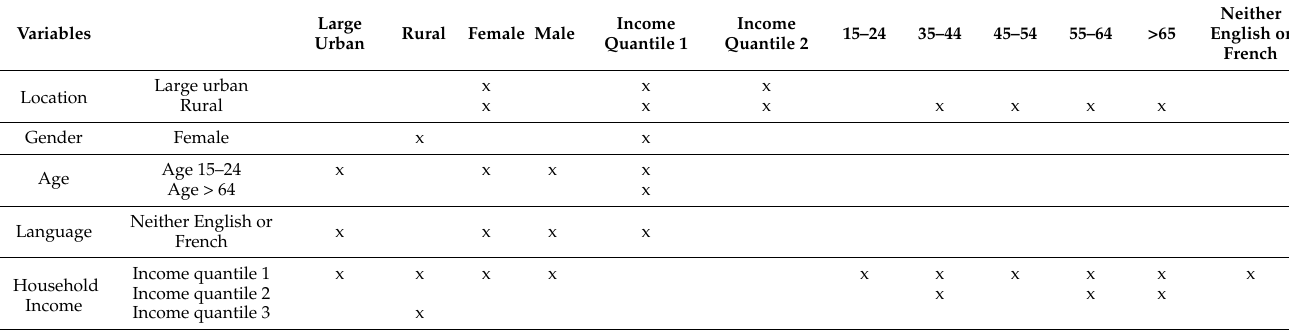
Table 3. Interaction